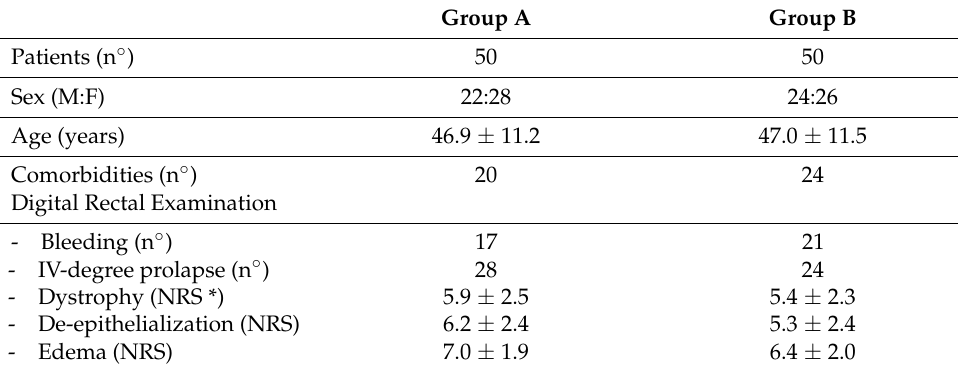
Table 1. Patients’ baseline